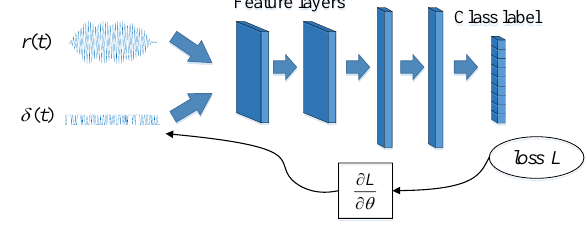
Figure 6. Diagram of AT for DL-based SEI.